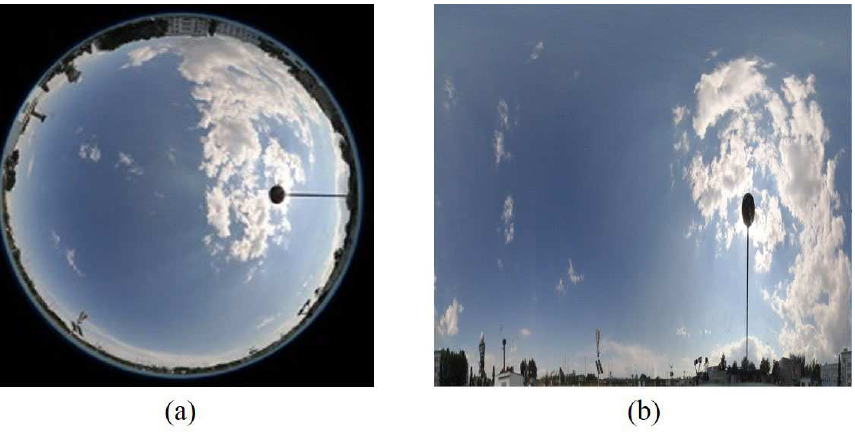
Figure 8. ( a ) The original cloud image, and ( b ) the cloud image after geometric